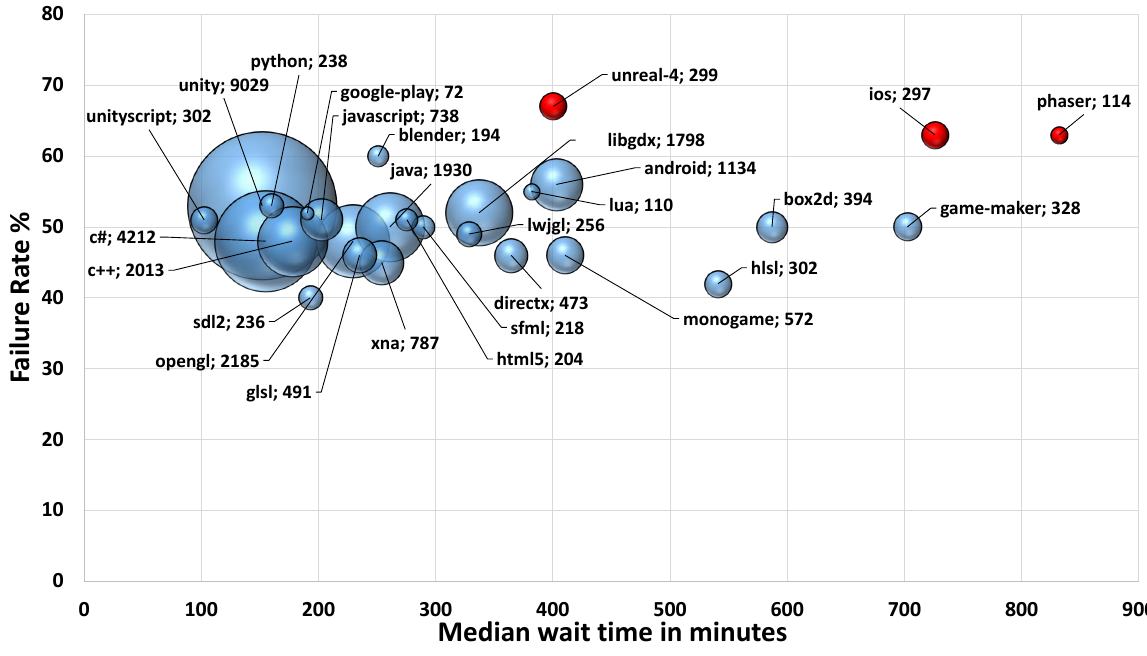
Figure 5. Failure Rate and Median Wait Time of most popular techs.